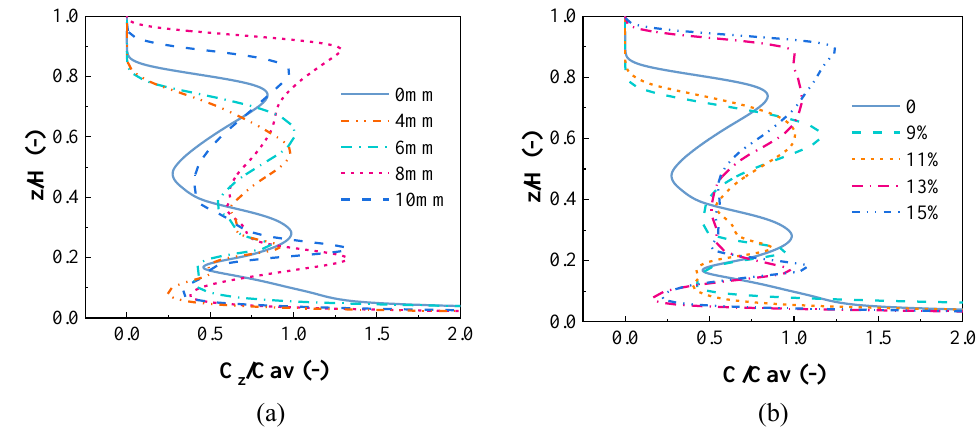
Fig. 15. Influence of aperture parameters on local axial solid concentration profile. (a) Influence of aperture diameter, (b) Influence of aperture ratio.